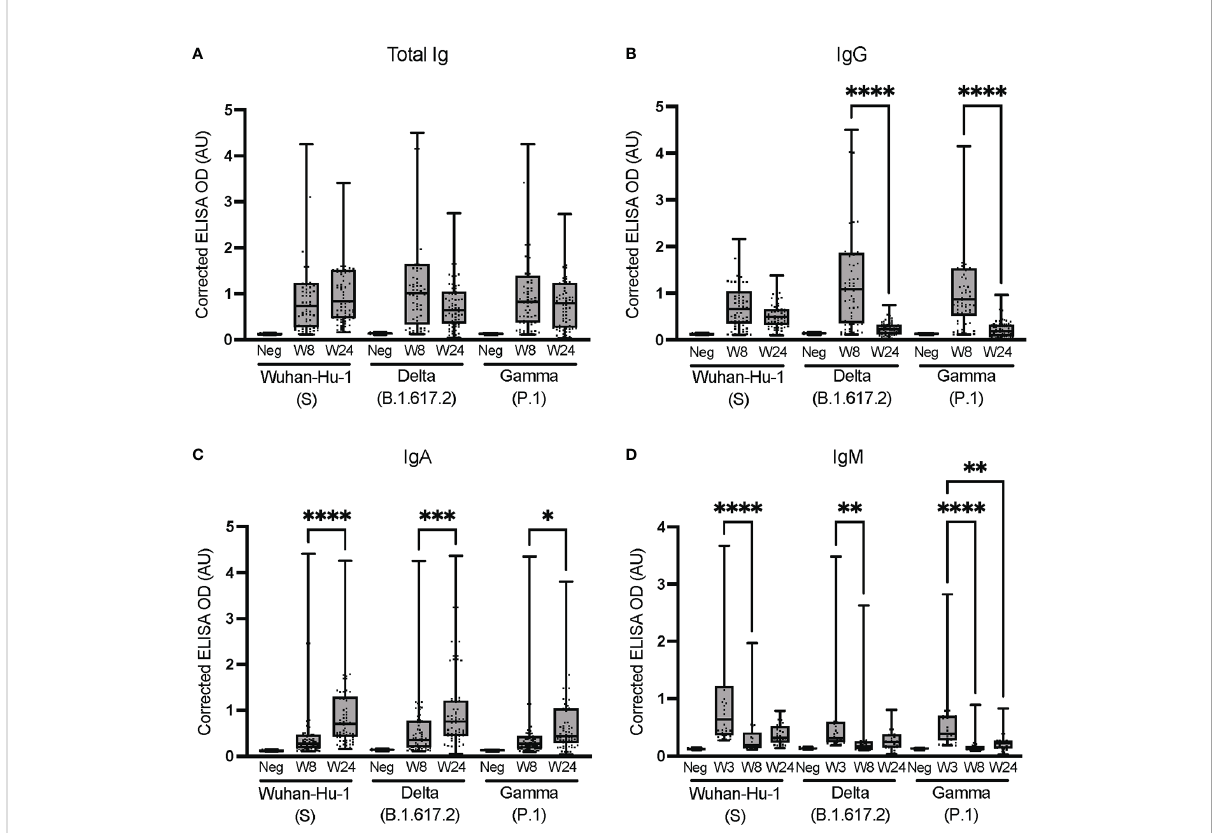
FIGURE 5 Cross-reactivity against the spike proteins of Wuhan-Hu-1 (S) and the Delta (B.1.617.2) and Gamma (P.1) VoC. Isotyping was conducted at the UdeM site to determine (A) Total Ig, (B) IgG, (C) IgA and (D) IgM against the spike protein of VoC. Serum samples are from the same individuals as in Figure 3 and include W8: n = 65 and W24: n = 67 individuals except for B.1.617.2 IgA at W24 where n = 64. For IgM, 30 samples were tested at W3, W8 and W24. The secondary antibodies are listed in Table 2. The average of triplicate assays is given as D OD 450-595 (corrected OD). The average of triplicate assays is given as corrected OD. The median is shown in the quartile boxplots where the whiskers include all values (no outliers excluded). Negative controls (Neg) using serum from eight SARS-CoV-2-negative individuals are given as the average of triplicate assays. *p < 0.05; **p < 0.01; ***p < 0.001; ****p < 0.0001. Results for the seroconversion ROC analyses for these datasets are presented in Supplementary Table